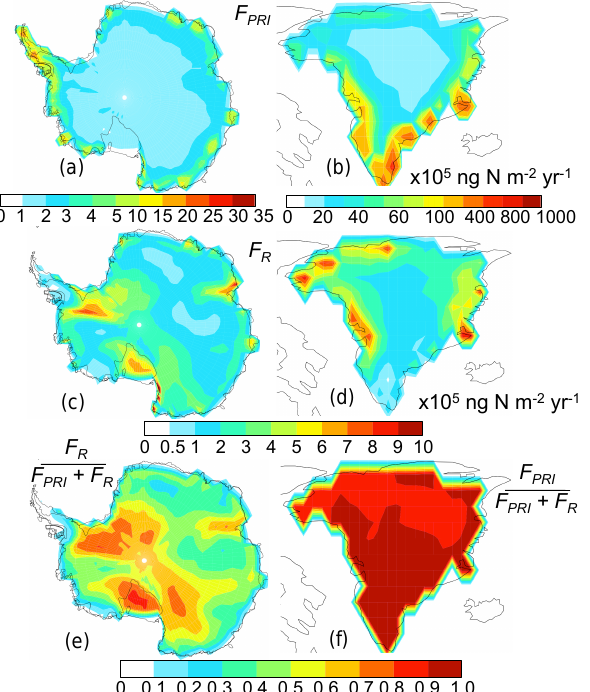
Figure 6. (a, b) Annual wet plus dry deposition flux of primary NO − to the snow ( F PRI ) . (c, d) Annual wet plus dry deposition 3 flux of recycled NO − to the snow ( F R ) . (e) Ratio of F R to the total 3 ) for the base-case scenario. (f) Ratio downward NO − flux ( F R F PRI + F R 3 ) . of F PRI to the total downward NO − flux ( F PRI F PRI + F R 3